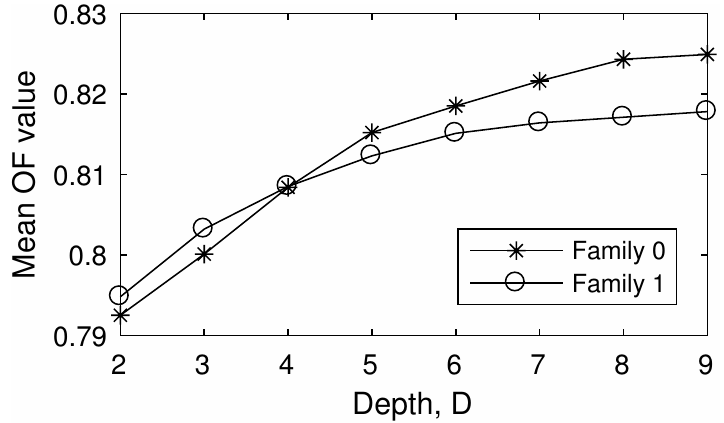
Figure 1. Minimum value of OF according to depth D for Family 0 and Family 1.